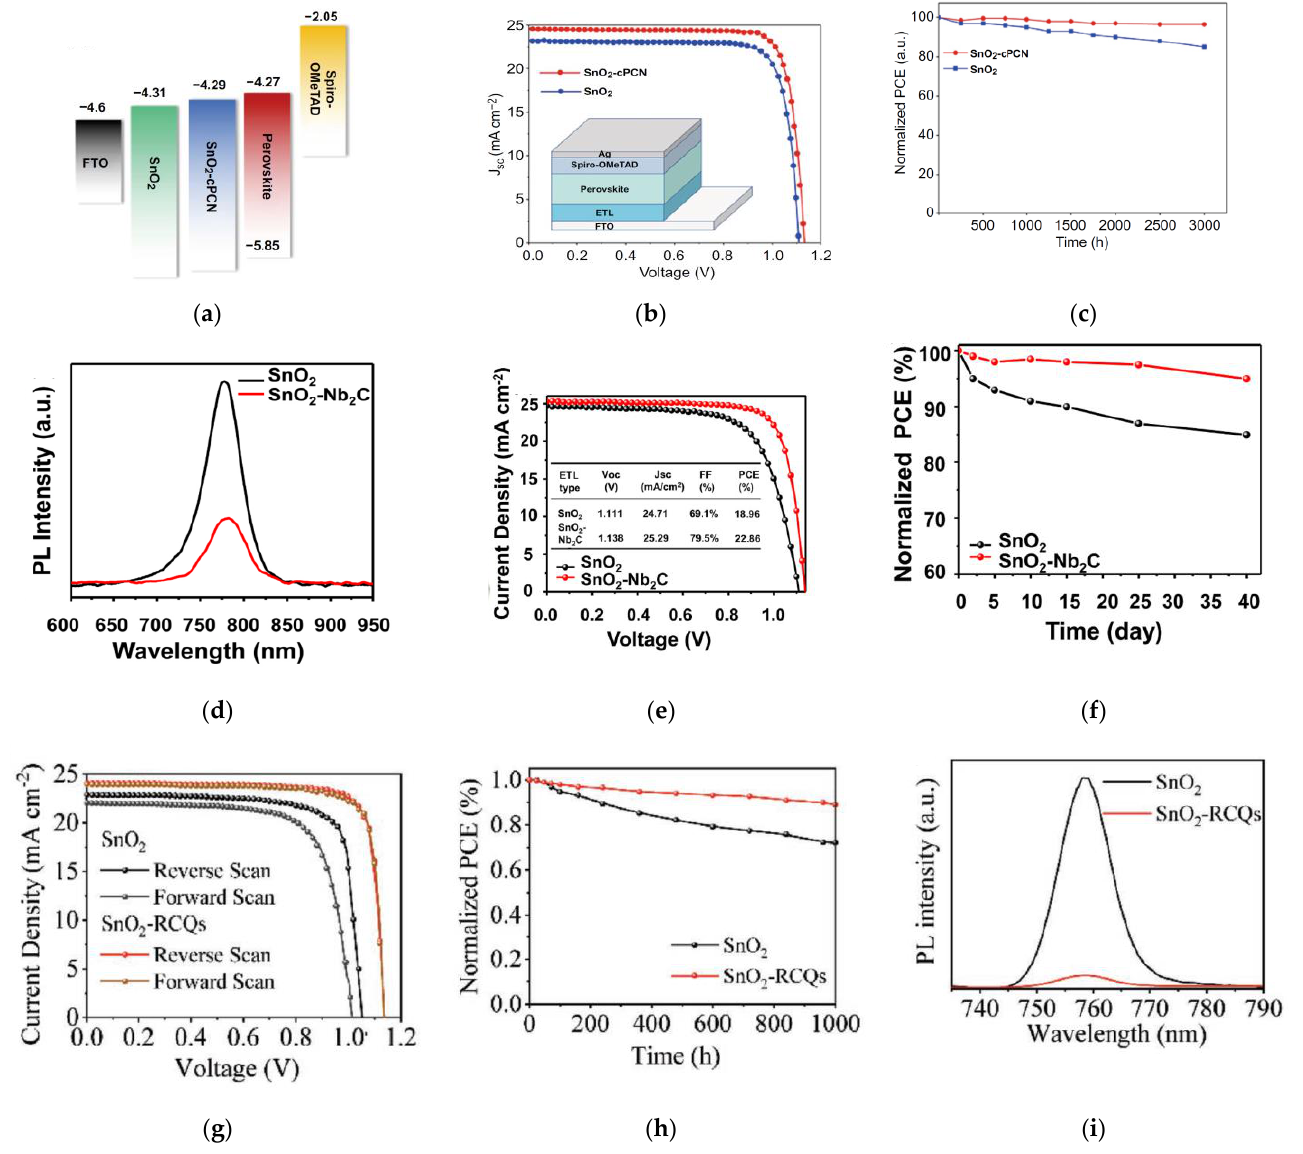
Figure 6. ( a ) Energy-band level of each layer in the PSC. ( b ) Illuminated J - V curves under 1 SUN for SnO 2 and cPCN:SnO 2 -based devices. ( c ) Long-term stability measurements of unencapsulated devices in N 2 . Reproduced from [63] with permission from Springer, 2021. ( d ) PL spectra of perovskite film grown on various ETLs. ( e ) Illuminated J - V curves under 1 SUN for SnO 2 and Nb 2 C:SnO 2 -based devices. ( f ) Long-term stability measurements of devices with different ETLs. Reproduced from [64] with permission from Elsevier, 2021. ( g ) Illuminated J - V curves under 1 SUN for reverse and forward scans of SnO 2 and carbon quantum dot:SnO 2 -based devices. ( h ) Long-term stability measurements of unencapsulated devices with different ETLs in ambient dark environment at 25 °C with 40 – 60% relative humidity. ( i ) Steady-state PL spectra of perovskite on varying ETLs. Reproduced from [65] with permission from Wiley, 2020.